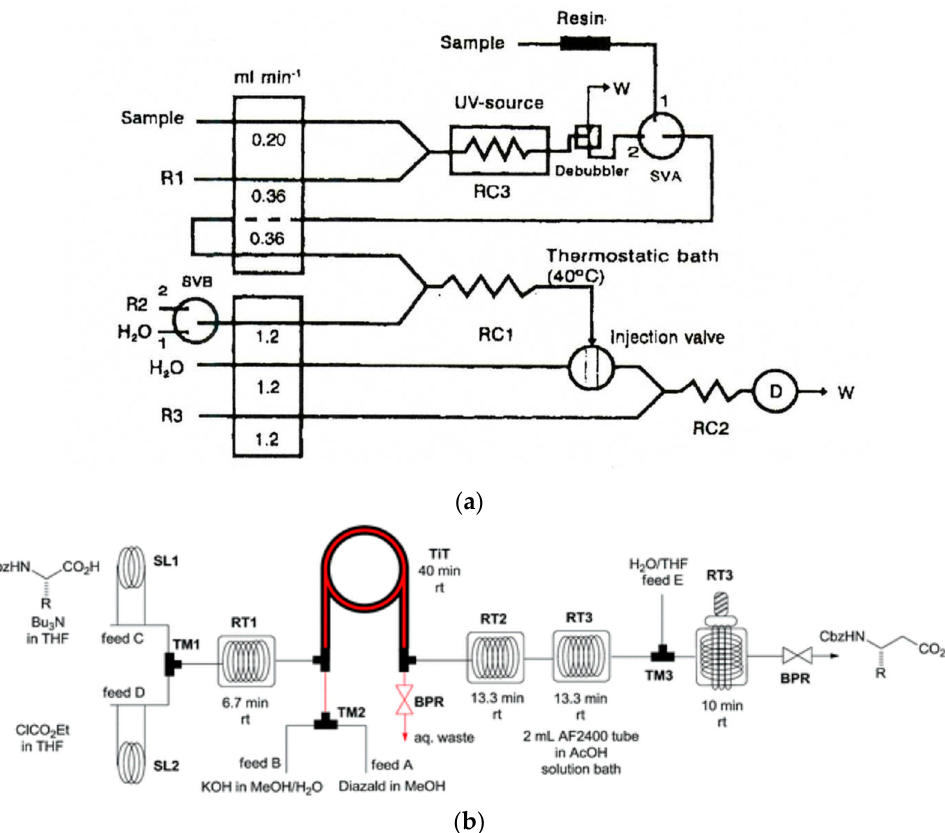
Figure 5. Examples of application of flow-through UV photoreactors in analytical ( a ) and synthetic ( b ) flow systems: ( a ) schematic diagram of flow-injection system with spectrophotometric detection for speciation of nitrogen in wastewater UV oxidation of organic species, nitrite, and ammonium into nitrate [118]; R1—persulfate alkaline solution; R2—reducing solution; R3—chromogenic reagent; resin—Amberlite XAD-7 sorbent; UV source—ultraviolet lamp; injection volume—90 μ L; SVA, SVB—selection valves; RC1, RC2—reaction coils; RC3—photo-oxidation coil (3 m × 0.5 mm inner diameter (id)); W—waste; D—detector (540–420 nm); ( b ) schematic diagram of flow system for continuous-flow synthesis of β -amino acids from α -amino acids with photochemically induced Wolff rearrangement [226]; SL—injection valves; TM—T-mixers; RT—residence loops; TiT—tube-in-tube reactor; BPR—back-pressure reactors; PRT—photoreactor.